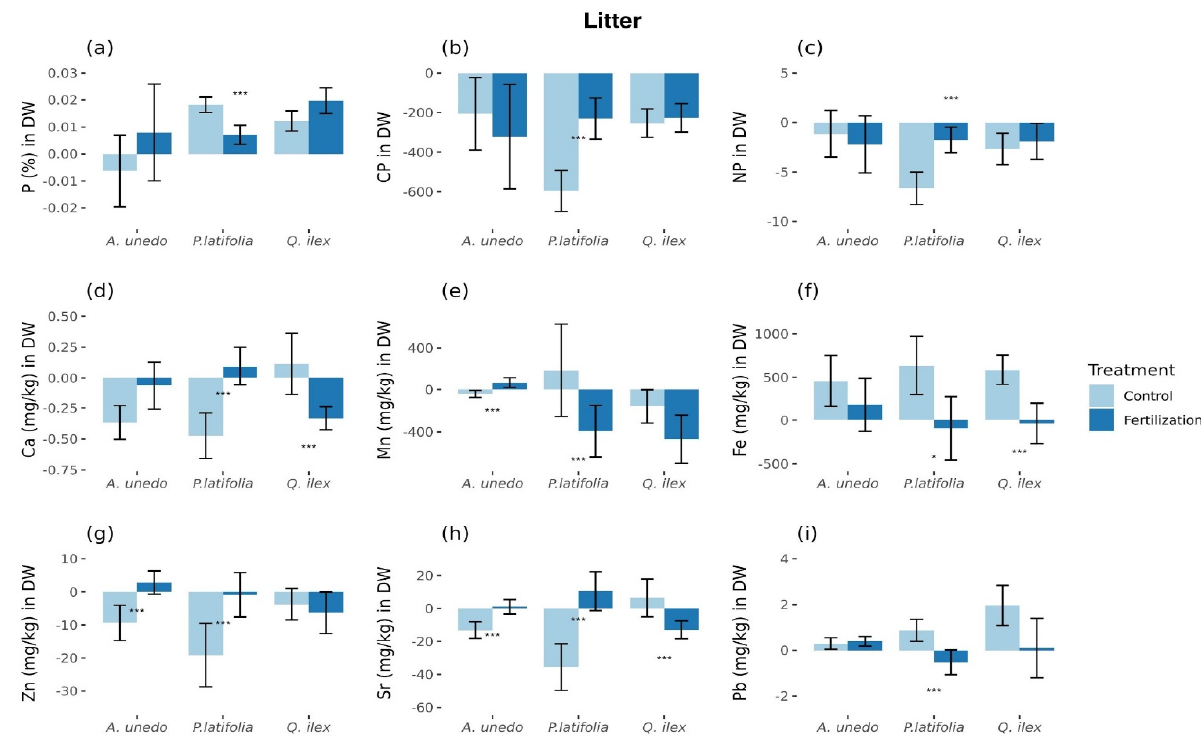
Figure 3. Litter elemental composition, ratios, and microelements statistically different between control and fertilized plots. The showed elements are: ( a ) P % in litter. ( b ) C:P in litter. ( c ) N:P in litter ( d ) Ca mg/kg in litter. ( e ) Mn mg/kg in litter. ( f ) Fe mg/kg in litter. ( g ) Zn mg/kg in litter. ( h ) Sr mg/kg in litter. ( i ) Pb mg/kg in litter. Values are relatives to original values in 2014 and are expressed in % of change. * = Marginal significance ( p = [0.05, 0.1]). *** = Significant differences ( p < 0.05). Figures with standard error.